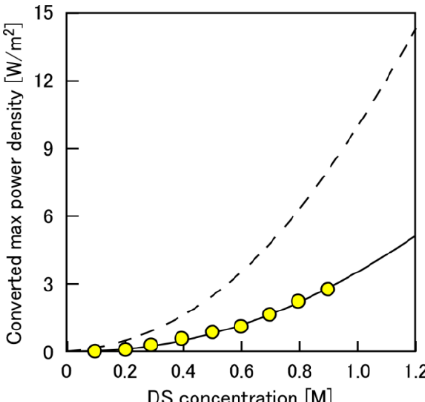
Figure 7. Equivalent pressure differences in the PRO process as a function of CDS. Circles, the applied pressure difference at the maximum power density; triangles, the half value of Δ P at zero water flux obtained from the J w -Δ P curve (1/(2Δ P Jw=0 )); dashed line, the half value of Δ π between DS and FS (Δ π /2). PRO conditions: FS, tap water; Q DS,in : 4.0 L/min; Q FS,in ; 1.5 L/min.